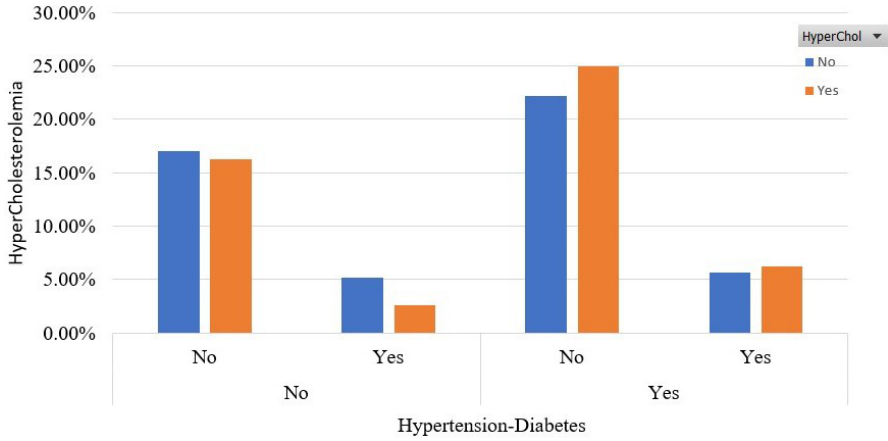
Figure 4. Participants’ distribution for both diabetes and hypertension in the balanced